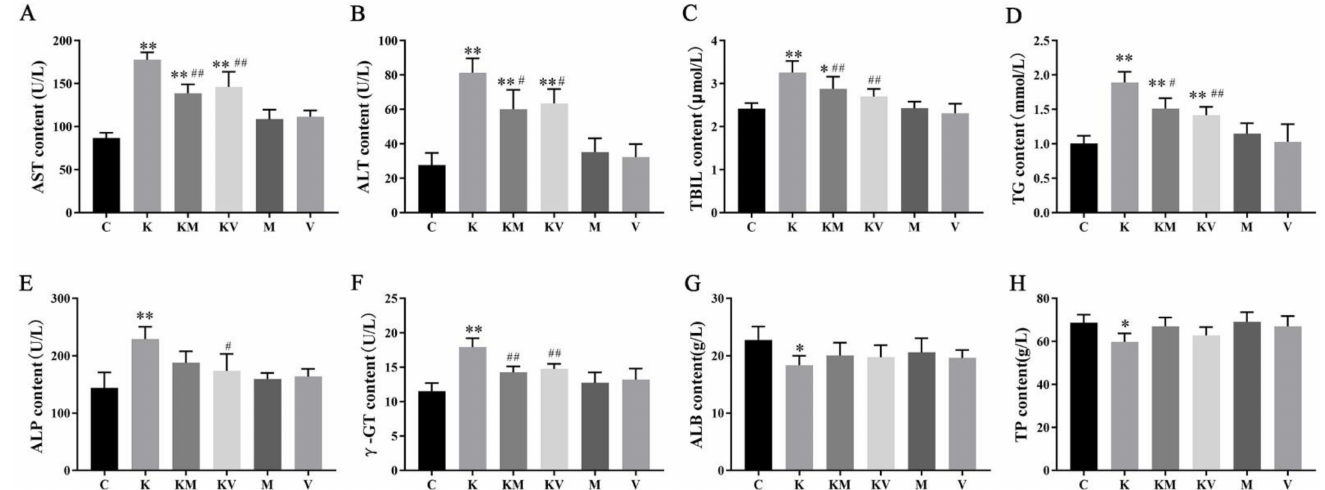
Figure 1. Effects of MCC950 and VX765 on ketamine induces liver function injury in neonatal rats. Serum level of ( A ) AST, ( B ) ALT, ( C ) TBIL, ( D ) TG, ( E ) ALP, ( F ) γ -GT, ( G ) ALB, and ( H ) TP ( n = 6). Results are the mean ± SD. * p < 0.05 vs. control group, ** p < 0.01 vs. control group; # p < 0.05 vs.